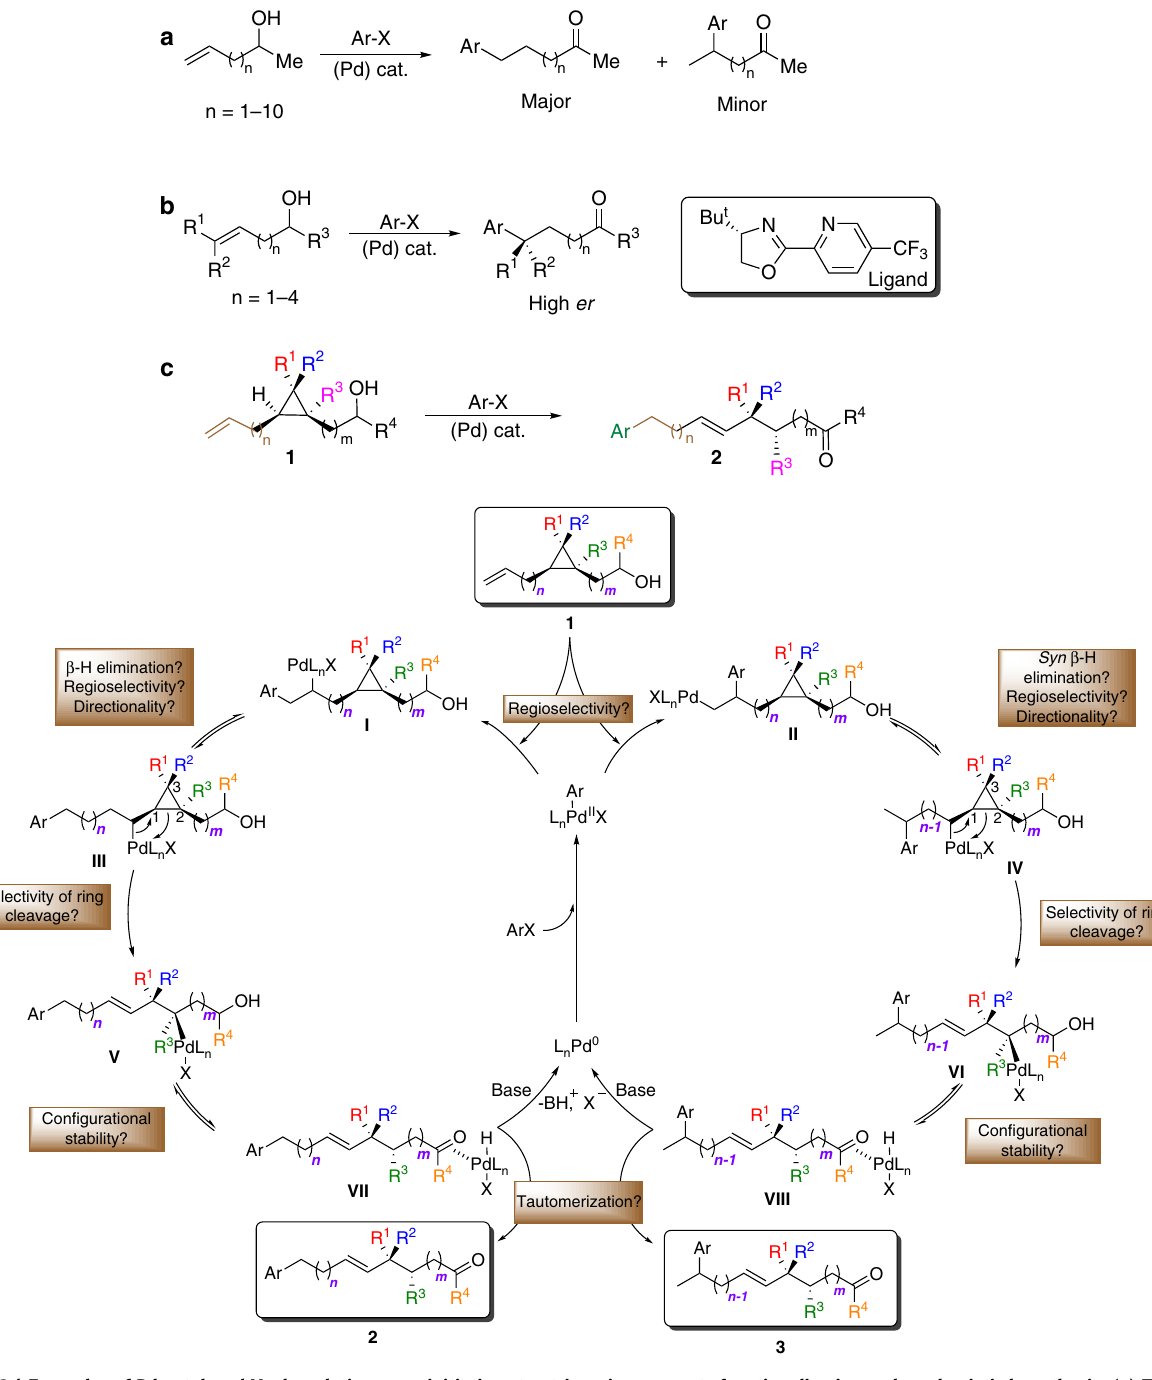
Figure 2 | Examples of Pd-catalysed Heck arylation as an initiation step triggering a remote functionalization and mechanistic hypothesis. ( a ) The first report of a Pd-intramolecular migration across a molecule was pioneered by Heck 35 and later extended by Larock 36 showing the versatility of the method across longer alkenyl chain. ( b ) Sigman reported the enantioselective and site-selective Heck reaction of diazonium salts, vinyl triflates, aryl boronic acids and indole derivatives with o -alkenyl alcohols 13,37–40 . ( c ) Proposed catalytic sequence and mechanistic hypotheses for the transformation of cyclopropane 1 into regioisomers 2 and/or